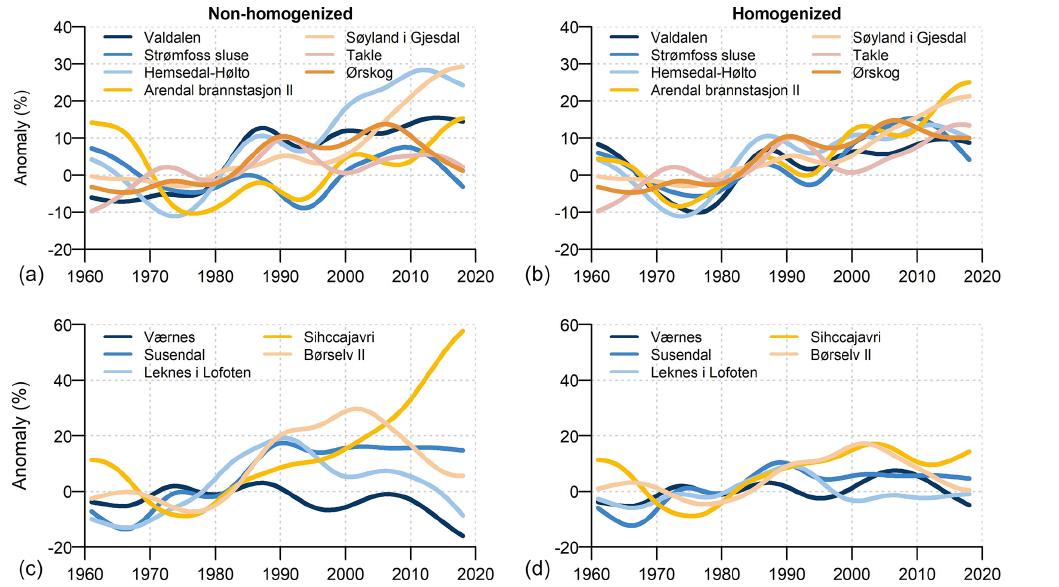
Figure 3. Deviation of the annual precipitation series (1961–2018) in percent with respect to 1961–1990 mean for series in different climatic regions in Southern (a, b) and Northern Norway (c, d) before (a, c) and after (b, d) homogenization. The anomaly series has been filtered using a 10-year Gaussian density function.